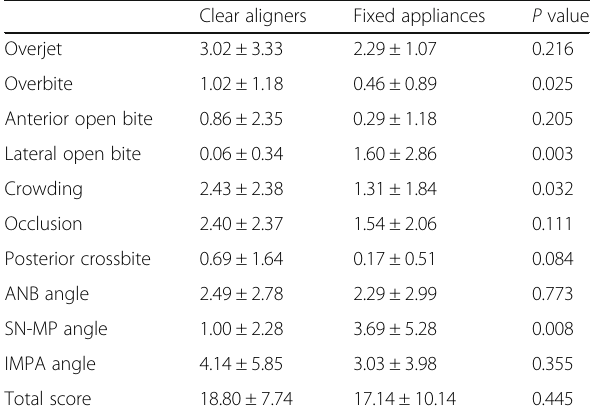
Table 2 Baseline discrepancy index (DI) of the two groups